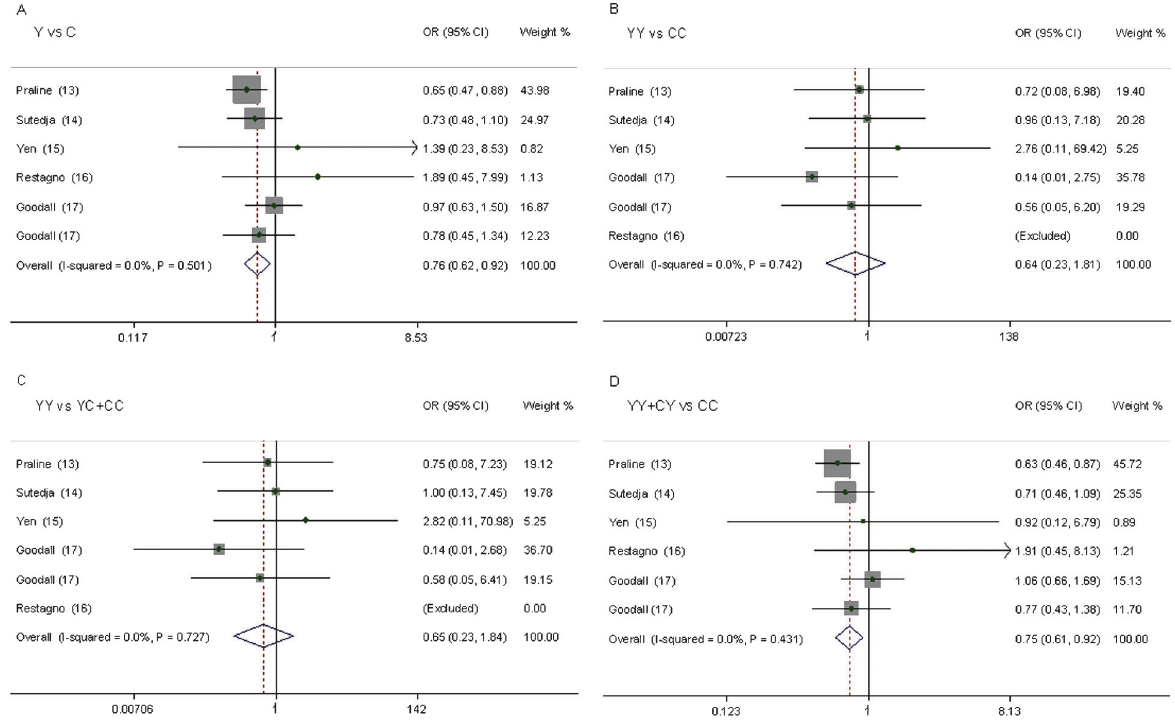
Figure 2. Forest plot of the assocition between ALS and the HFE C282Y mutation. A , Y vs C; B , YY vs CC; C , YY vs YC++CC; D , YY++CY vs